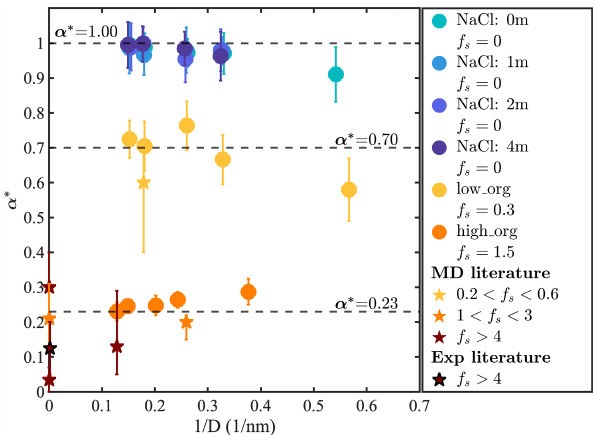
Figure 6. Normalized water accommodation coefficient α ∗ ver- sus 1 /D for different droplets. Circles show results calculated in this study. Stars show previous MD simulation (Ma et al., 2011; Chakraborty and Zachariah, 2008; Li et al., 2019; Takahama and Russell, 2011) and experimental results (Diveky et al., 2019; Duf- fey et al., 2013; Diveky et al., 2021) obtained at ambient tempera- ture categorized by their f s